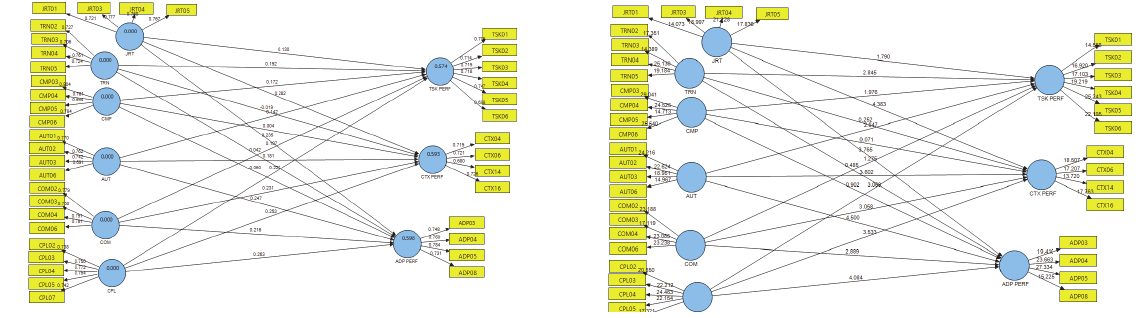
Fig. 2.1 Measurement Model (PLS Algorithm) Fig. 2.2. Structural model (PLS